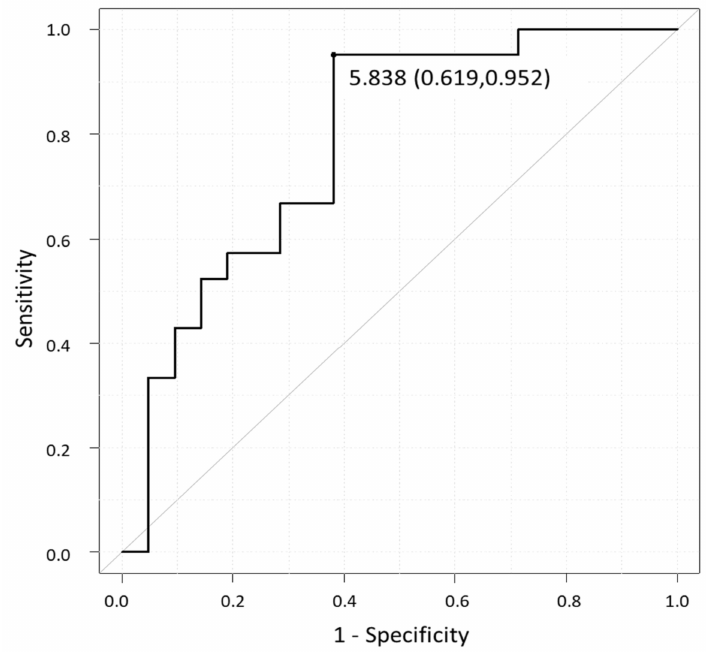
Figure 3. Receiver operating characteristic curve for MVPA. Cut-off value (specificity, sensitivity): 5.838 min/day (0.619, 0.952), AUC (95% CI): 0.773 (0.626–0.921). Abbreviations: MVPA, moderate-to- vigorous physical activity; AUC, area under the curve; CI, confidence interval.